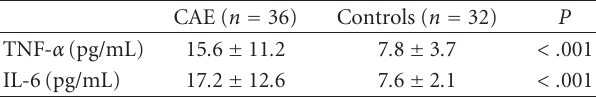
Table 2: TNF- α and IL-6 levels in the patients with CAE and control